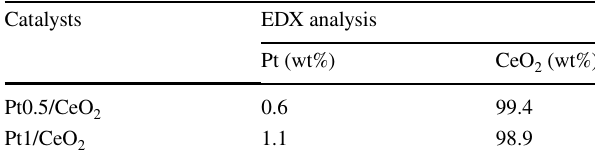
Table 1 Chemical composition of Pt/CeO